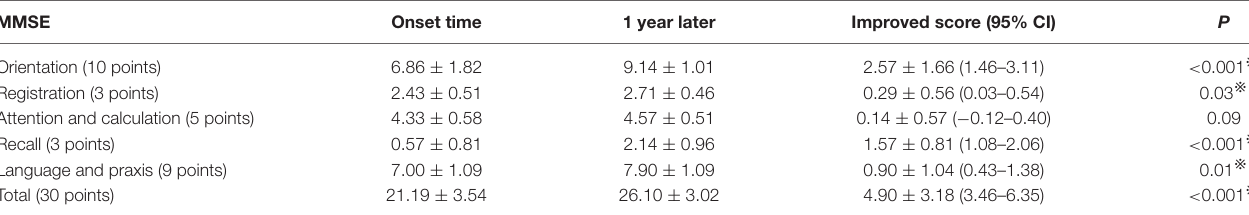
FIGURE 3 | Total scores of MMSE (A) and MoCA-B (B) of different patients. We separately list the different patient with total scores of MMSE and MoCA-B at the time of hospitalization and 1 year after discharge. (A) Show the distribution of the MMSE scores for the 21 cases. (B) Show the distribution of the MoCA-B scores for the 21 cases. No moderate to severe cognitive impairment (MMSE ≤ 20) was determined at 1 year (A) . MMSE, Mini-Mental State Examination; MoCA-B, Montreal Cognitive Assessment-Basic. TABLE 2 | Domains of MMSE test in patients with anti-LGI1 antibody encephalitis. MMSE Onset time 1 year